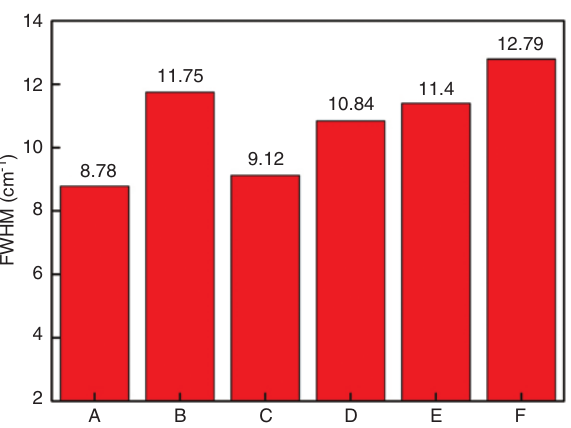
Figure 6: Raman spectra of diamond film samples obtained at various gas flow rates (sccm). (A) O Ar-14; (D) O -2, Ar-13; (E) O 2